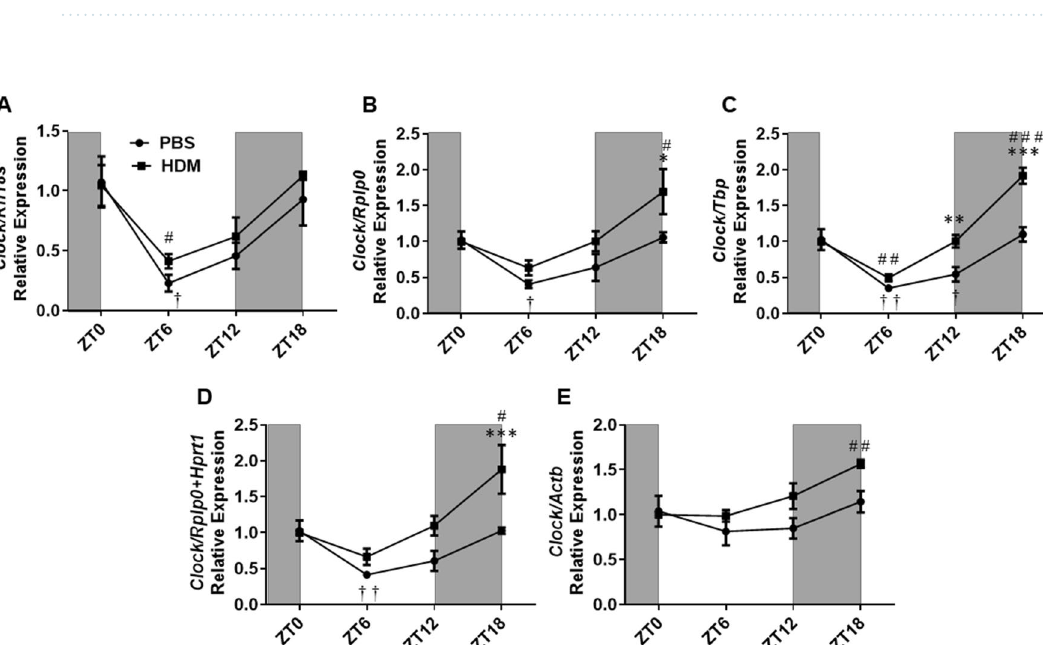
Table 2. Gene expression stability ranking by four different algorithms used in this study.